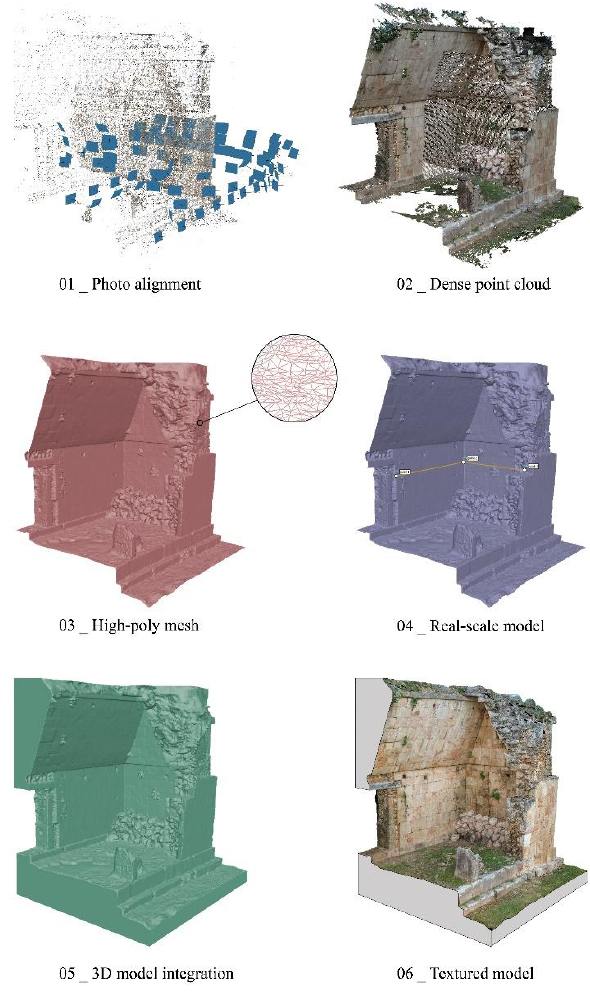
Figure 4. Modeling of a Maya vault from photogrammetric